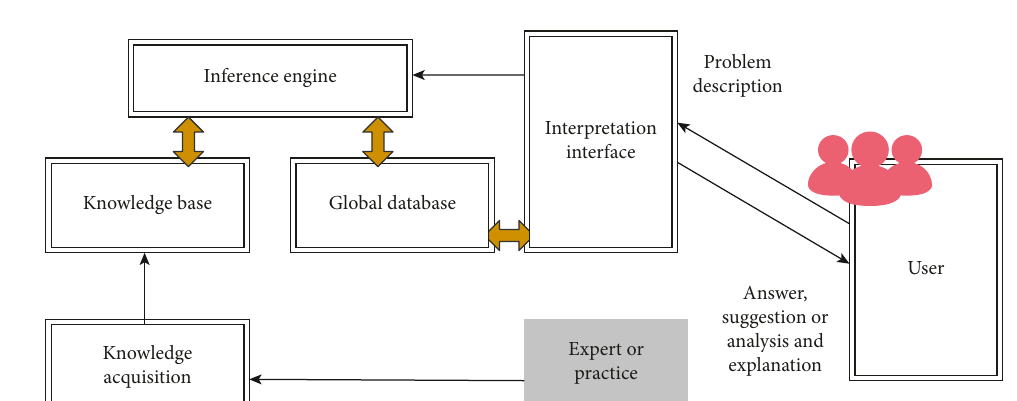
Figure 4: Top-level data-flow diagram.